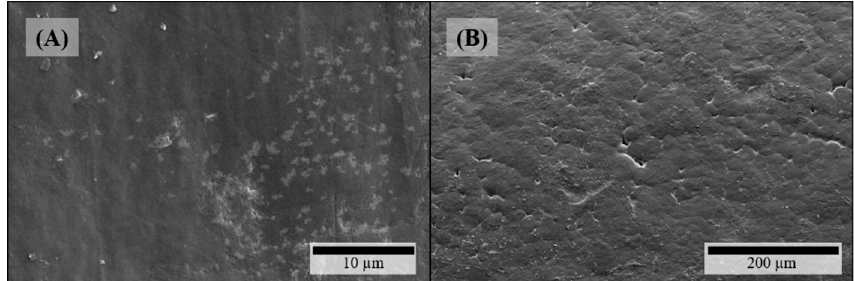
Figure 3. SEM pictures of filaments without any API: ( A ) HPMC surface; ( B ) PEO surface.